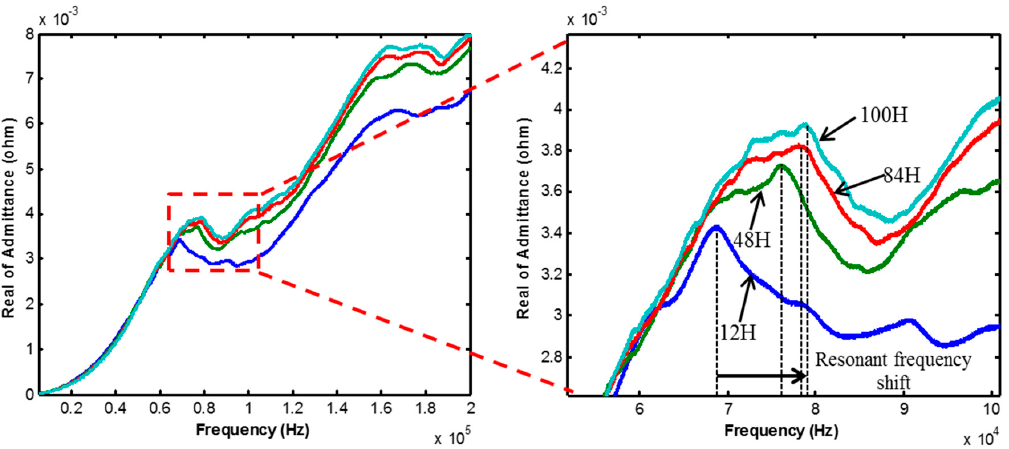
Figure 6. Electromechanical impedance (EMI) variation of module 1.